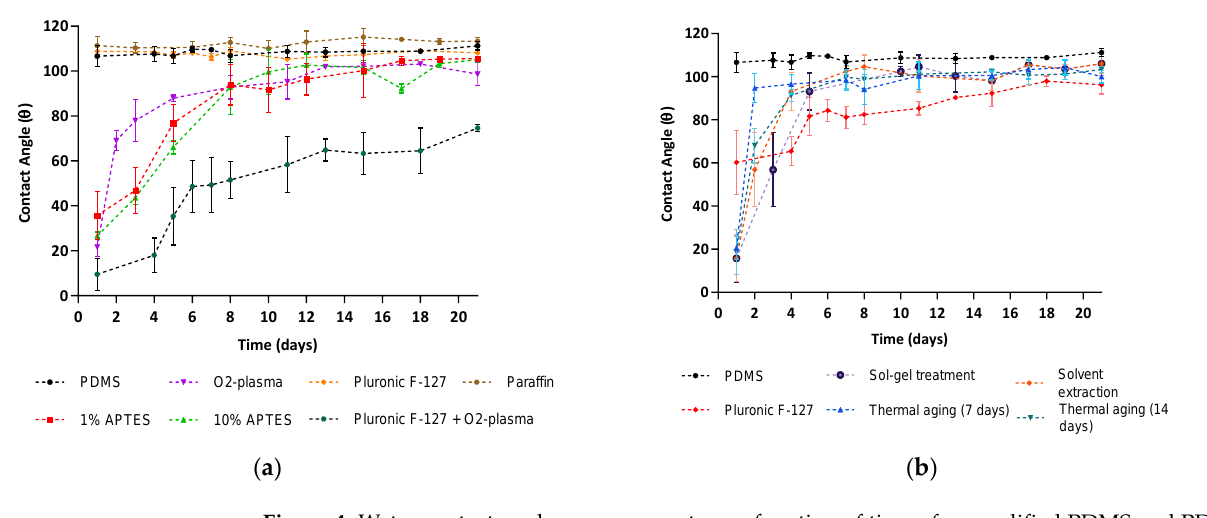
Figure 4. Water contact angle measurements as a function of time of unmodified PDMS and PDMS following ( a ) surface and ( b ) bulk modifications. Values show Mean ± SD from at least three independent measurements.